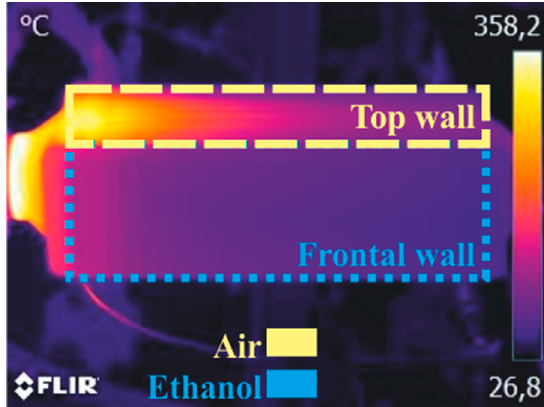
Figure 4. Schematic view of the thermographies.